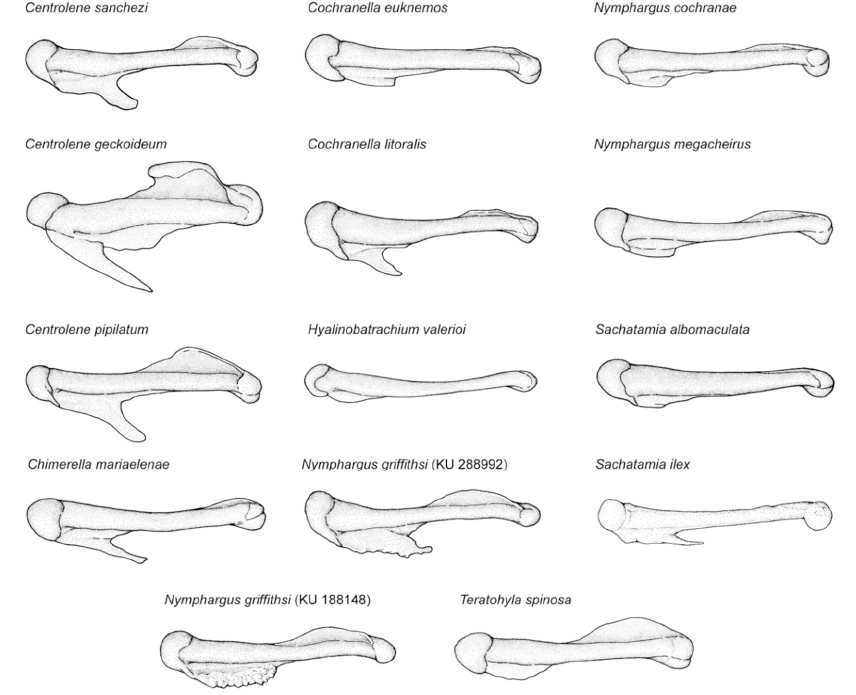
Figure 14. Variation of humeral spines, crista medialis , and crista ventralis , in adult males of Centrolenidae (modified from Guayasamin et al. [1]). Illustrated specimens are: Centrolene sanchezi , KU